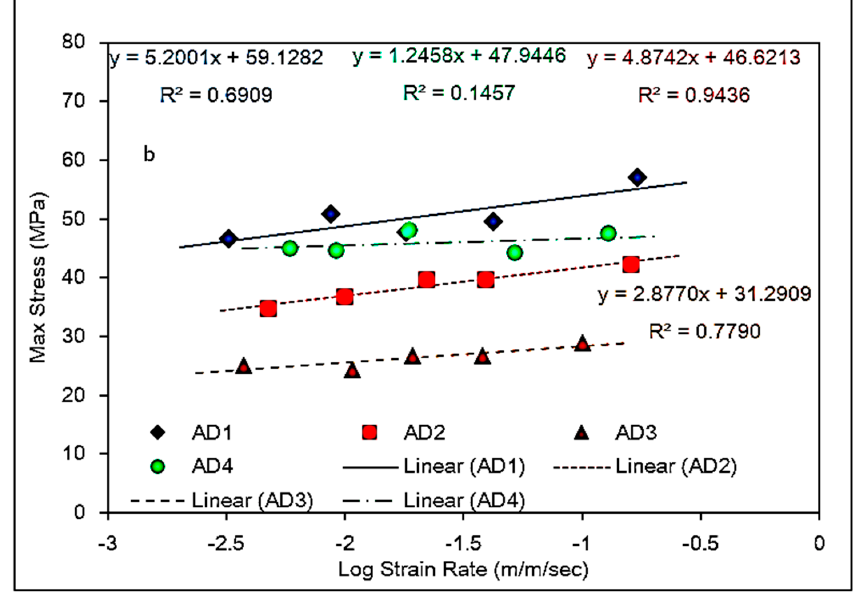
Figure 21. Variation of the maximum stress, σ Max as a function of strain rate during tensile tests.